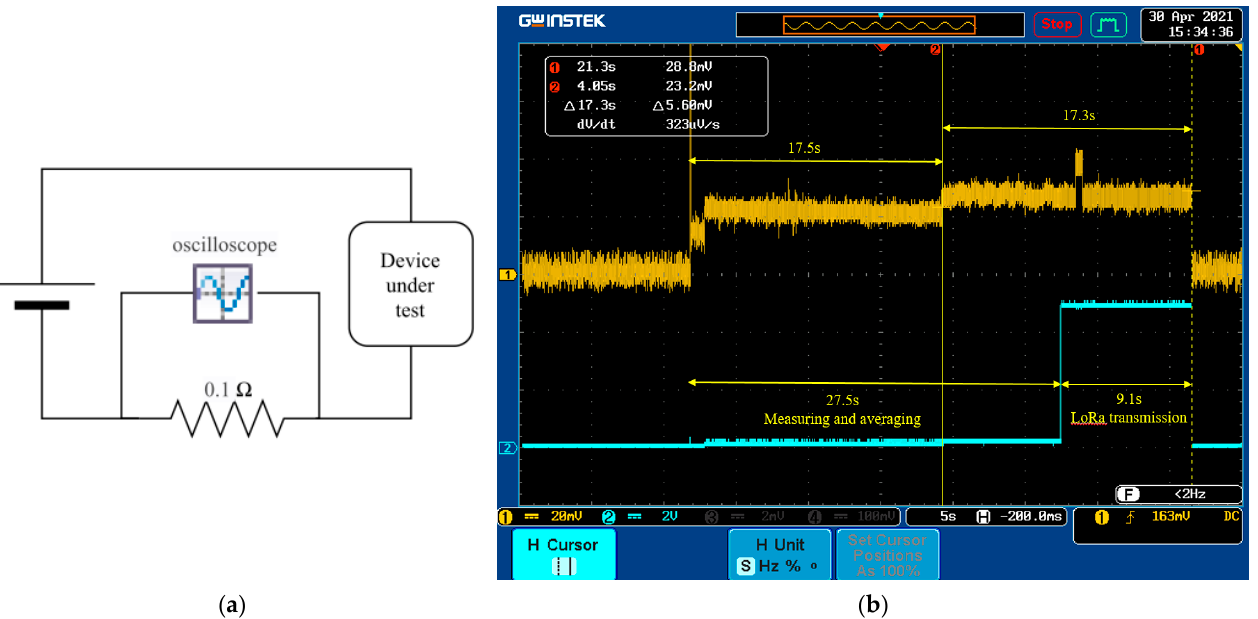
Figure 13. The test configuration ( a ) and a snapshot of digital oscilloscope ( b ).